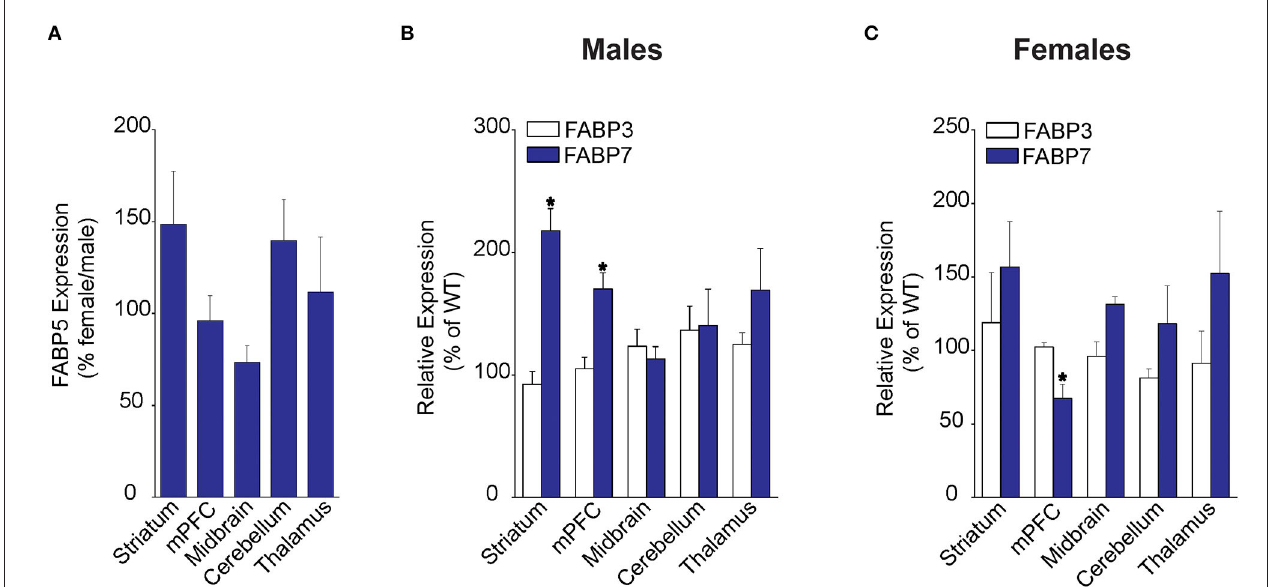
FIGURE 1 | Regional FABP expression in male and female WT and FABP5 KO mouse brains. (A) Comparative FABP5 expression in WT male and female mice in various brain areas was assessed by qPCR ( n = 5). Data are presented as percent expression in female/male mice. (B,C) Relative expression of FABP3 and FABP7 in male and female FABP5 KO mice compared to WT controls ( n = 5). *, p < 0.05; KO vs. WT.